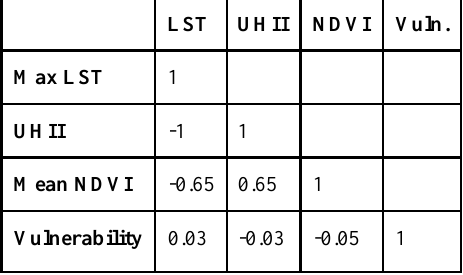
Table 4. Pearson correlation coefficients for Dallas.